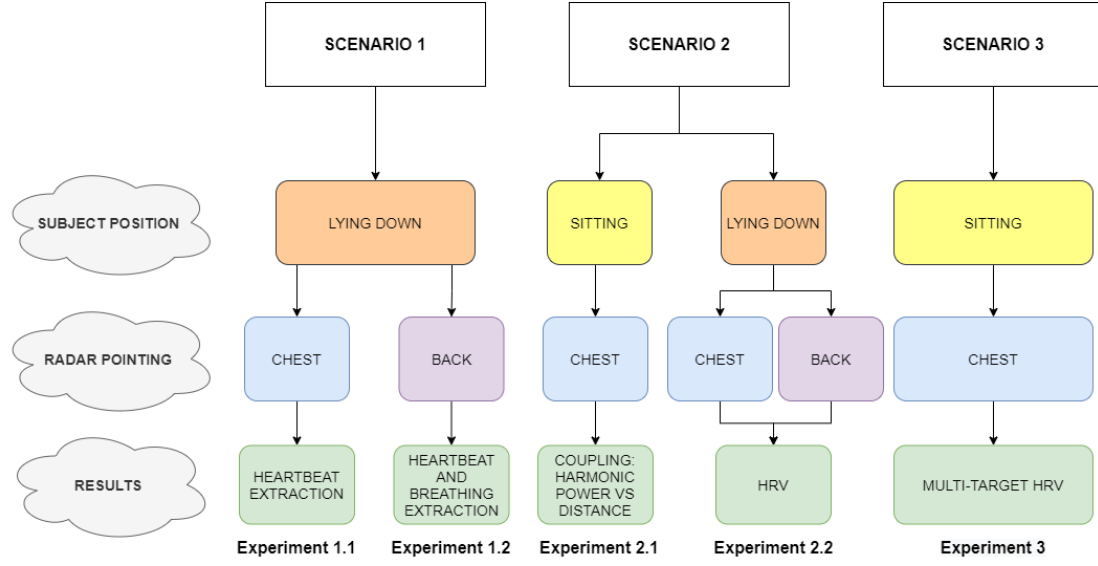
Figure 10. Scheme of the experiments carried